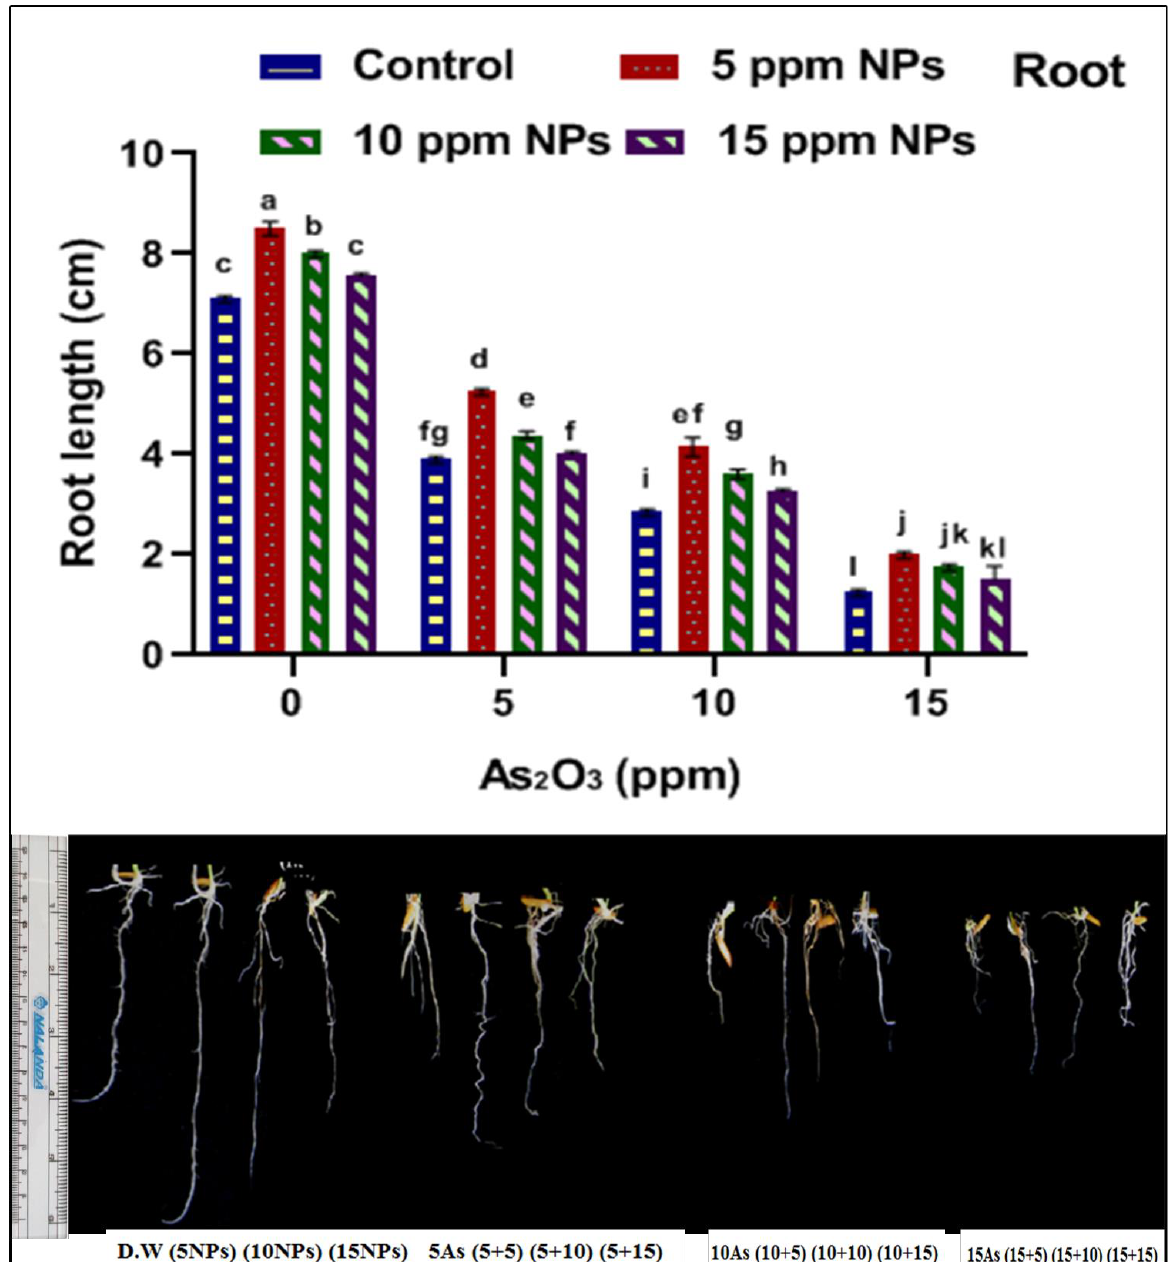
Figure 4. Effect of Bacillus subtilis -synthesized Fe 3 O 4 NPs on root length of rice ( Oryza sativa L.) in arsenic-contaminated water. Different letters show a significant difference at p < 0.05 between treatments.